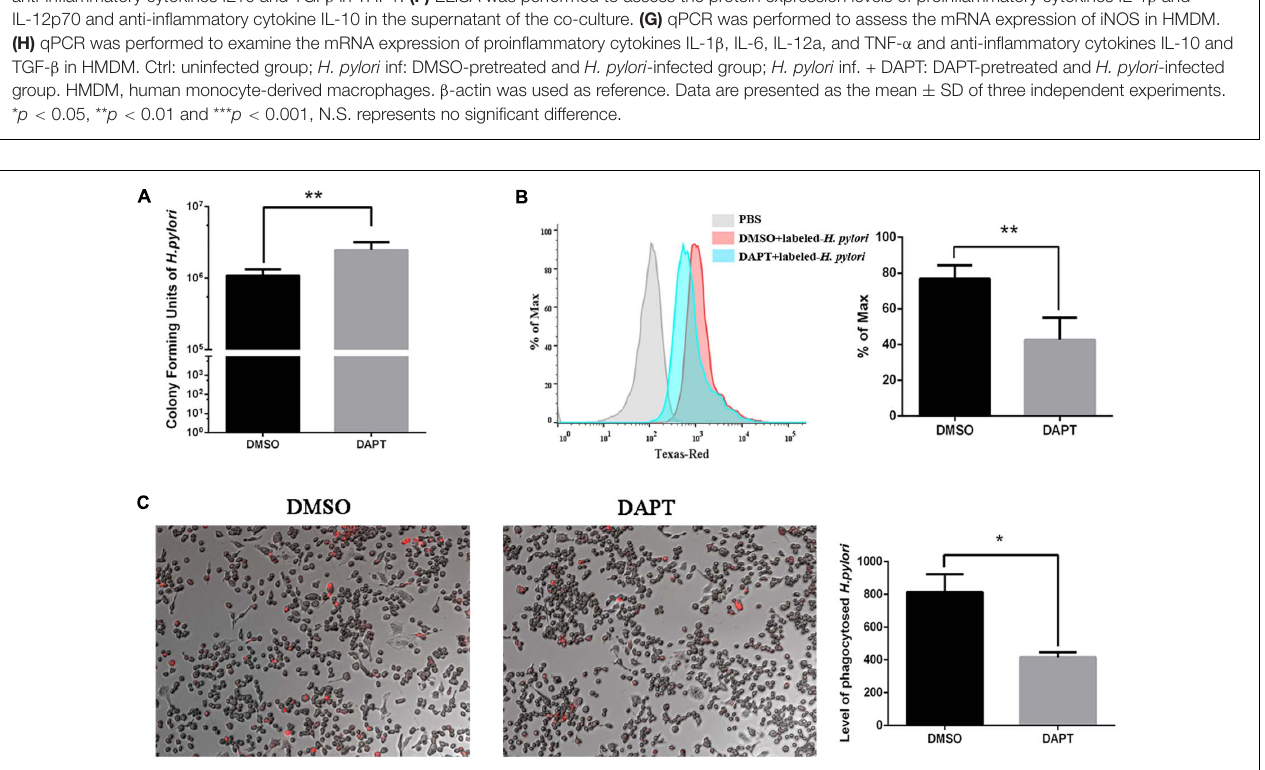
is associated with the bactericidal activities of macrophages